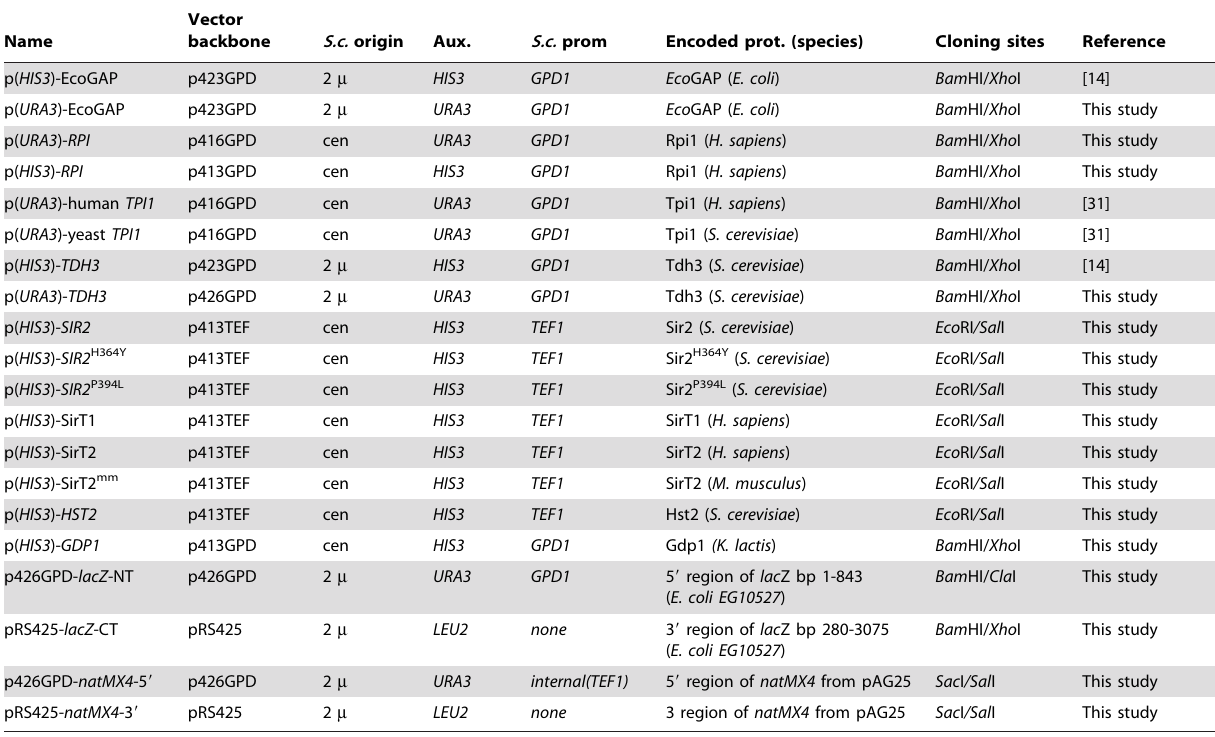
Table 1. Plasmids used in this